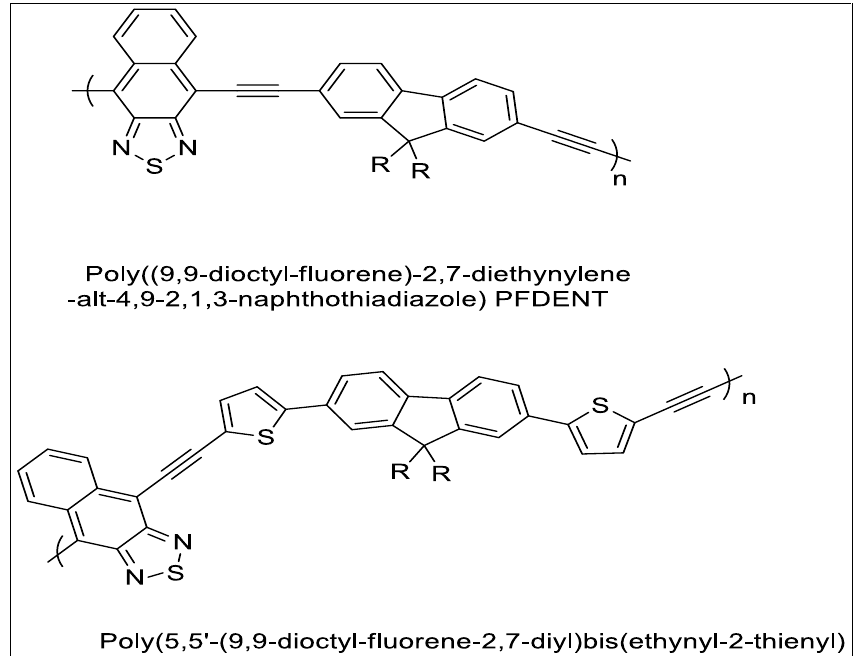
Figure 1. Structures of PFDENT and PFDTENT.